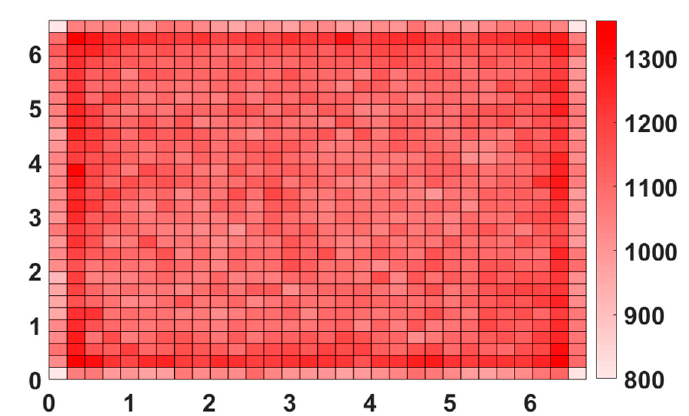
Figure 7. Node distribution for RW mobility.